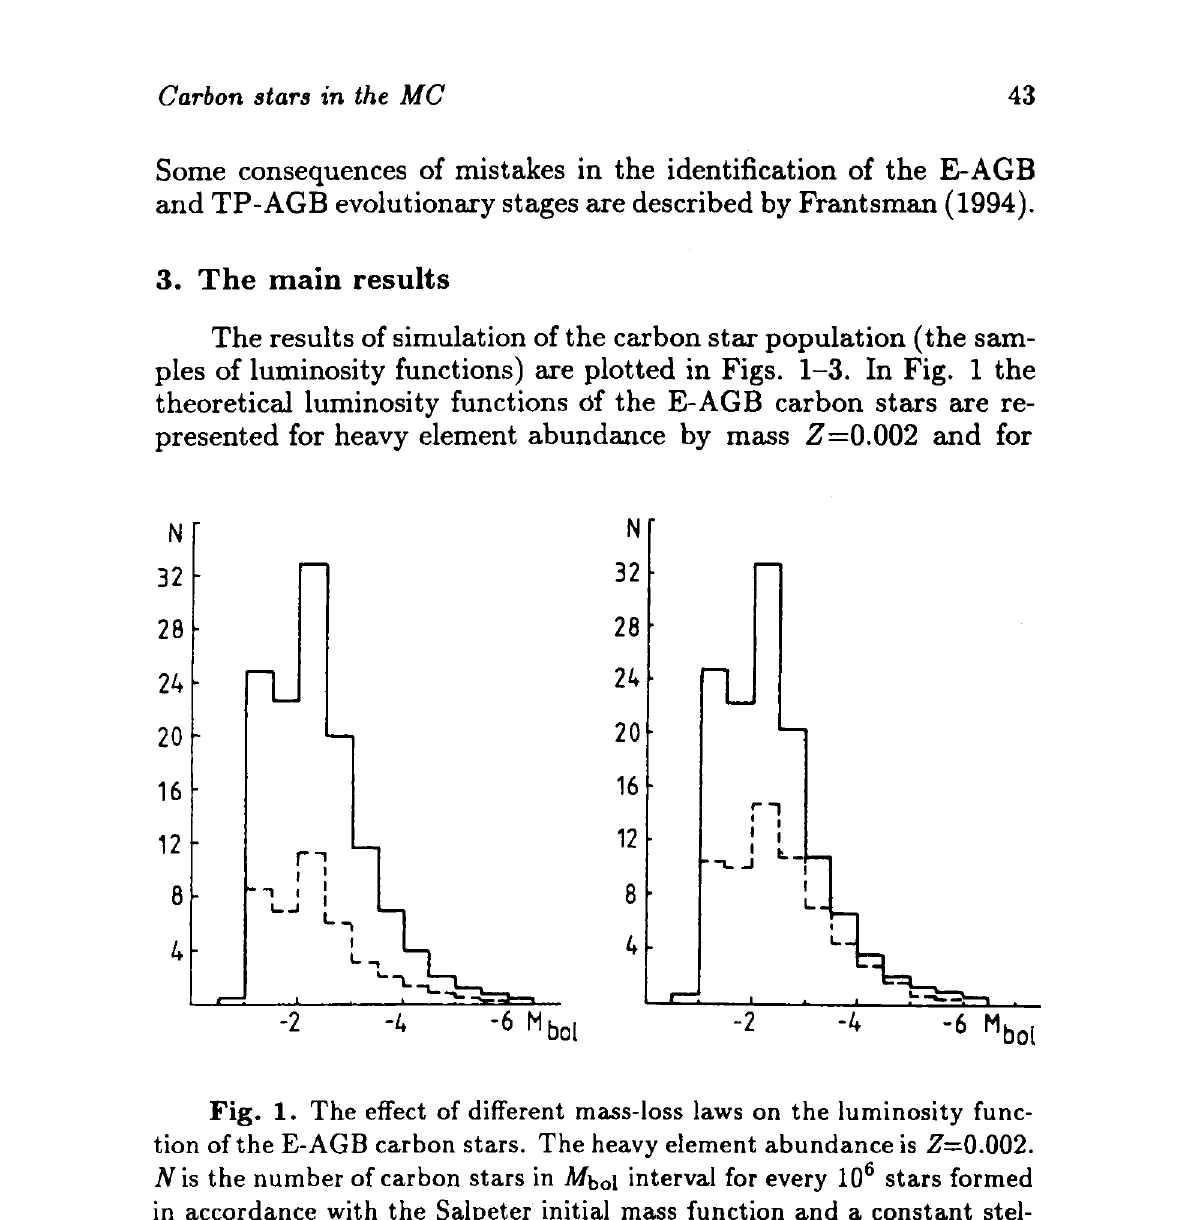
Fig. 2. The effect of different heavy element abundances Z on the luminosity function of the E-AGB carbon stars. N is described in Fig. 1. The solid line is for Z=0.002 and the dashed line is for